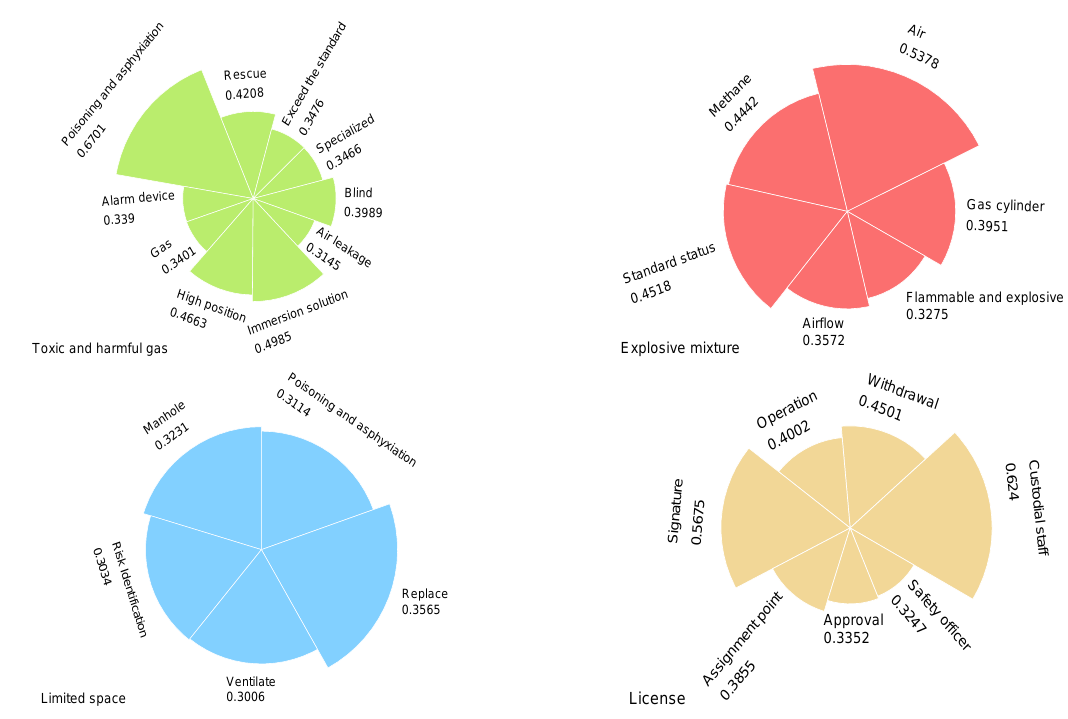
Figure 8. The heat map of correlation coefficients.